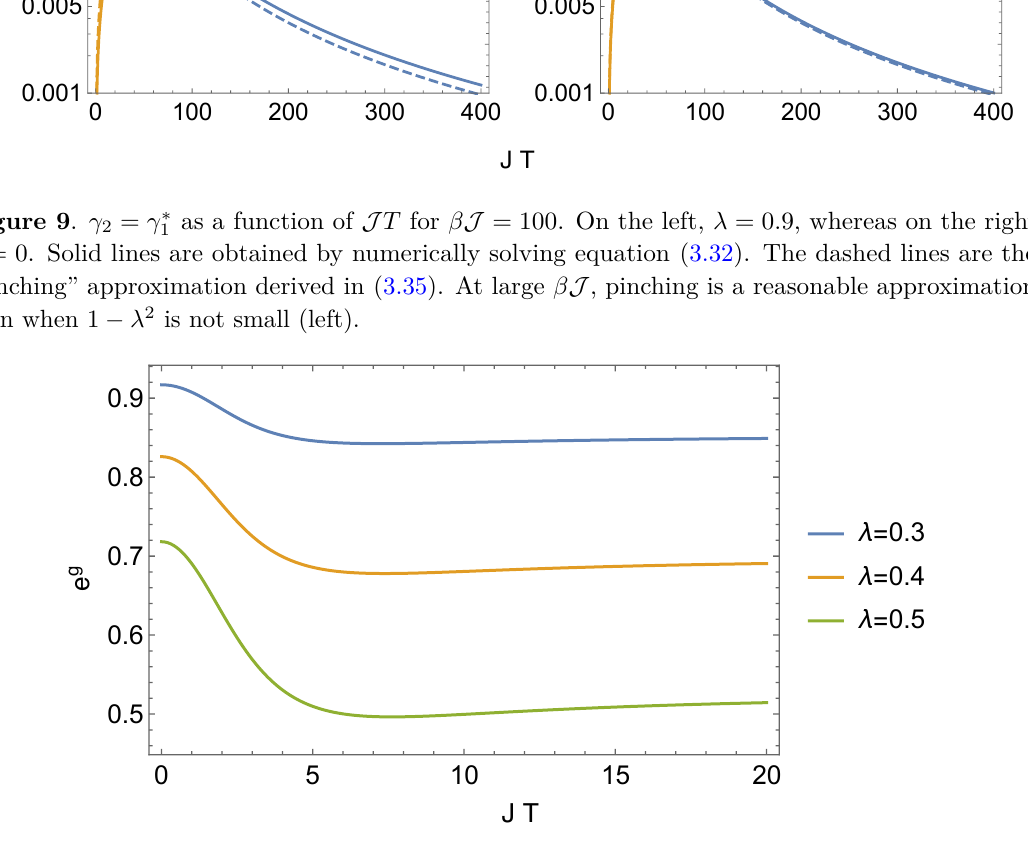
Figure 10 . Here we show the disk contribution to the 2-pt correlator e g ( t 1 ,t 2 ) evaluated at the quench sites ( t 1 = 0 , t 2 = β/ 2 + iT ) for λ = 0 . 3 , 0 . 4 , 0 . 5 , and β J = 5 . Note that at small values of λ the correlator stays large, which indicates that the distance between the quench sites is staying relatively small, even at large Lorentzian times. This is qualitatively similar to the Schwarzian behavior where the geometry gets pinched by the